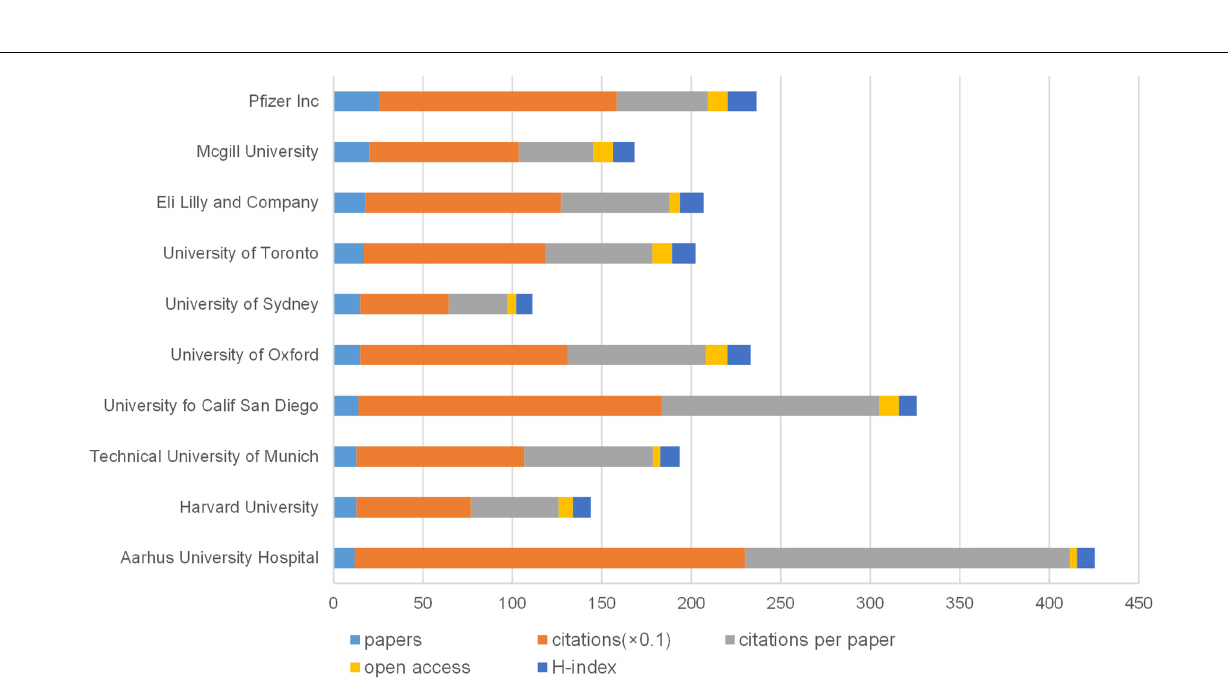
FIGURE 8 | The number of articles, citations, citations per paper, open access articles, and H-index of the top 10 institutions.